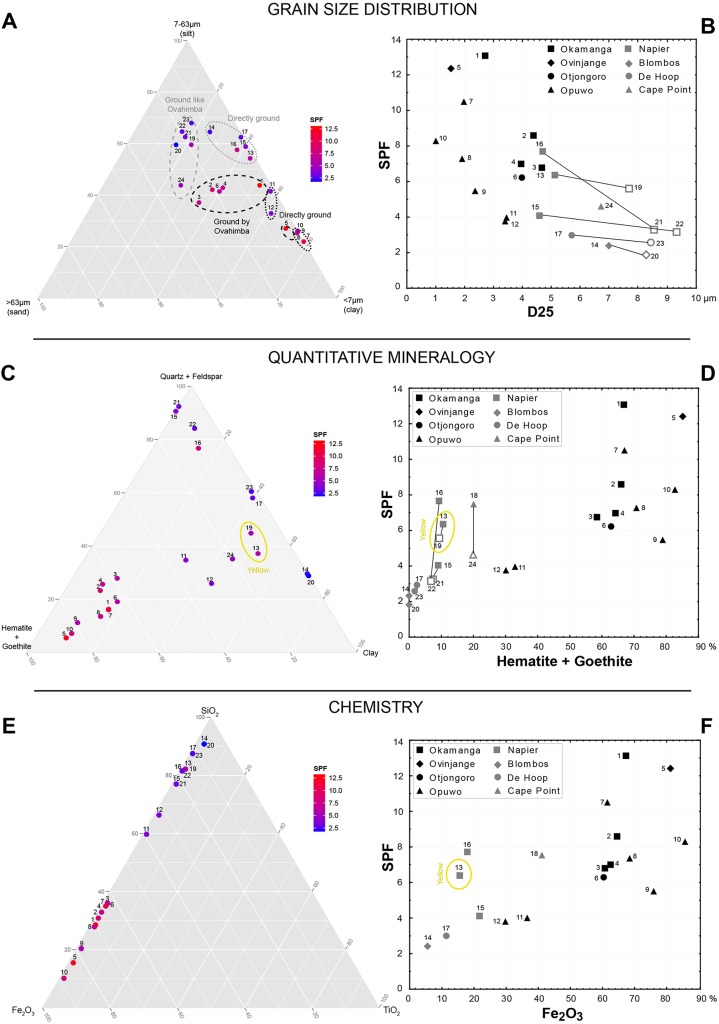
Ternary diagrams and biplots illustrating the relationship between SPF and grain size composition (A, B), mineral content (C, D) and elemental composition (E, F).